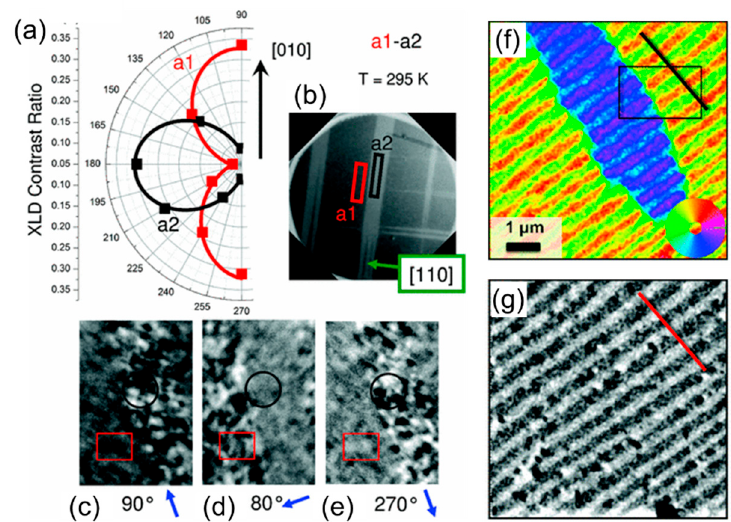
Figure 3. ( a ) Angular dependence of linear dichroism in CFO at Fe L 2 edge for a1-a2 type BTO domains at 295 K, with XLD domains in ( b ) measured at θ = 180 ◦ and arrow indicating the in-plane [110] substrate direction. ( c – e ) X-ray magnetic circular dichroism (XMCD) domains in 7 µ m × 11 µ m area for a1 (stripe with red box) or a2 (stripe with a black circle) domain variants for various angles θ with the x-ray incidence direction shown with small arrows, showing uniaxial in-plane magnetic anisotropy. Adapted from reference. Reprinted with permission from [71], copyright the American Physical Society, 2012. ( f ) Scanning electron microscopy with polarization analysis (SEMPA) image of CoFe magnetization (direction indicated by the color wheel) and ( g ) simultaneously acquired BSE image of underlying ferroelectric domain structure. Reprinted with permission from [41], copyright the American Physical Society, 2013.